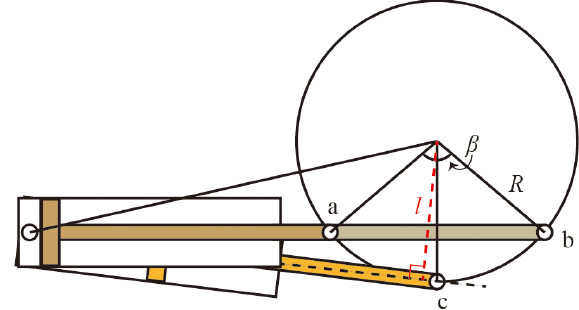
Figure 2. Actuator motion design.